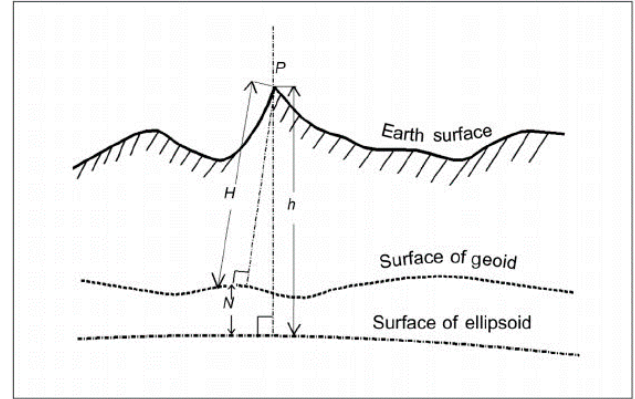
Figure 6. Geoid height ( 𝑁 ) definition as difference between the ellipsoidal height ( ℎ ) and orthometric height ( 𝐻 ) of a topography point [9].